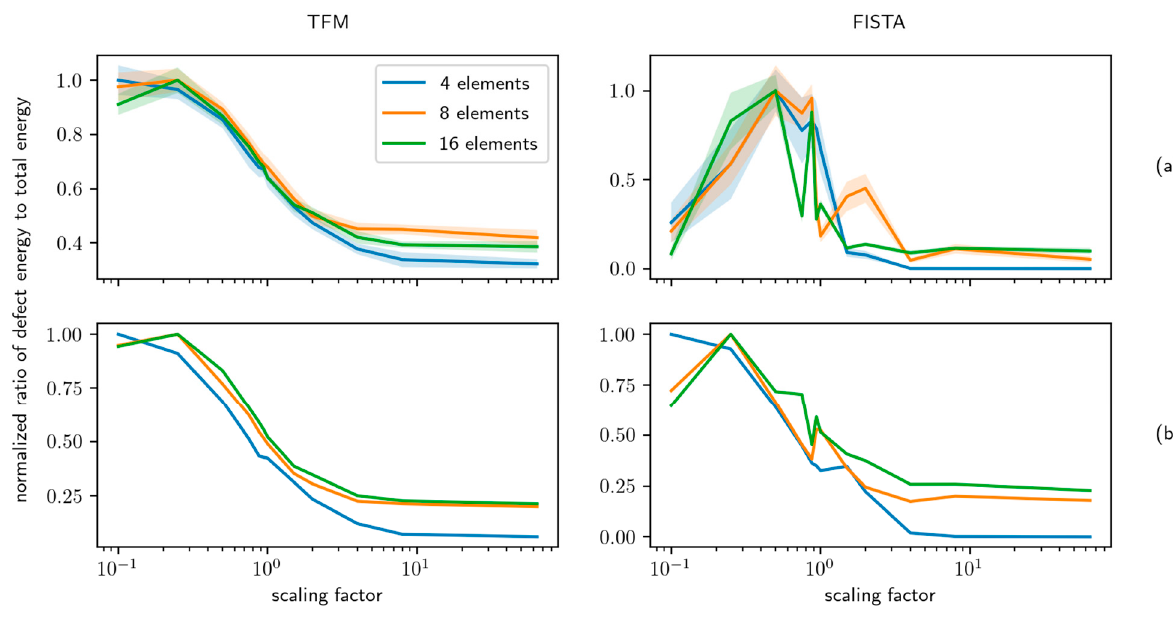
Figure 7. Performance of the reconstruction for the proposed transmit pattern selection scheme if the underlying model deviates. The deviation is simulated by interpolation of the original 𝒄 , the scaling factor refers to the distributions shown in Figure 6. The row ( a ) displays the results for a circular defect at 𝑧 = 13 mm , the row ( b ) for a defect at 𝑧 = 15 mm . The proposed transmit subsampling scheme yields the measures at scaling factor 1. For each scaling factor 10, noise realizations are evaluated, the opaque error range of each graph indicates the according standard deviations.